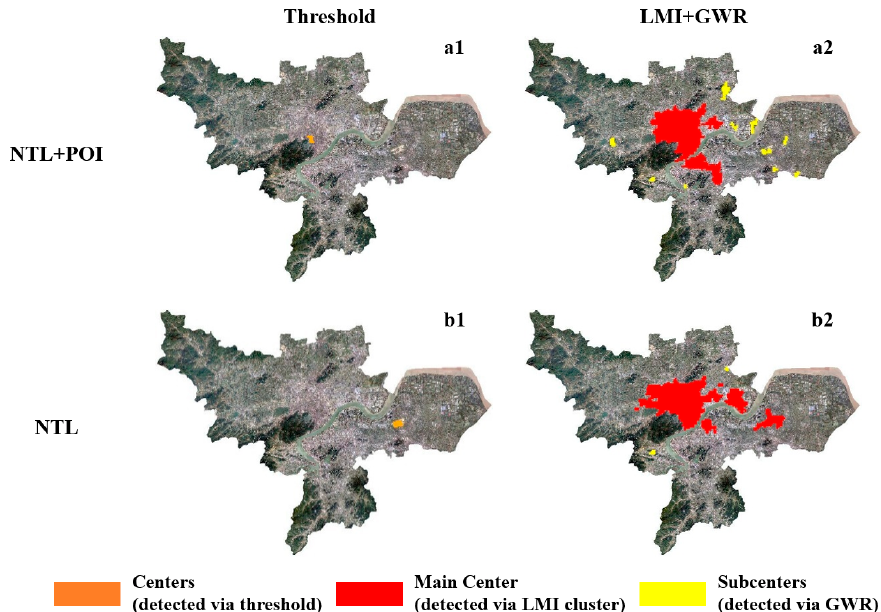
Figure 11. Centers detected by different methods and datasets. All centers detected by threshold are shown in orange. In the results from the Local Moran’s I (LMI) and geographically weighted regression (GWR) methods, the main centers are shown in red, and the subcenters are shown in yellow .